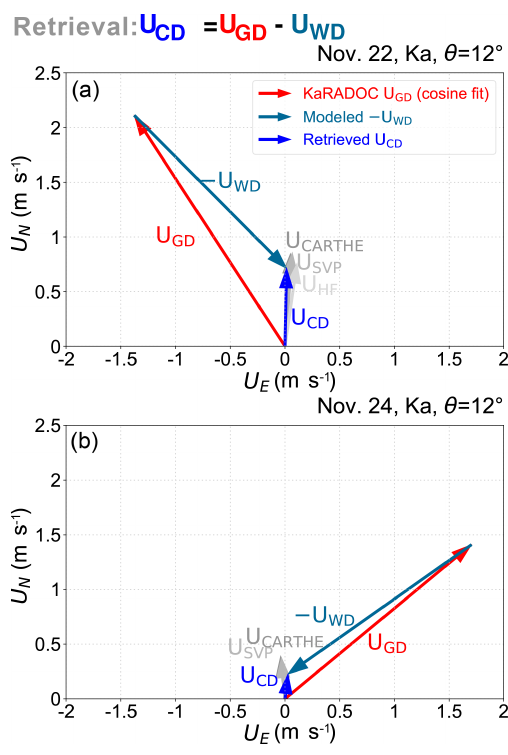
Figure 13. KaRADOC Doppler velocity (red circles) for the star- pattern flights on (a) 22 and (b) 24 November. Cosine function fits to the data (red lines). Modeled geophysical Doppler velocity U GD using the MEM (MLM) estimate of the directional wave spec- trum (green and darker green). The modeled U GD is the sum of the CARTHE drifter velocity U CD (blue) and the wave Doppler ve- locity estimated from the measured spectra, U WD (midnight blue dashes).